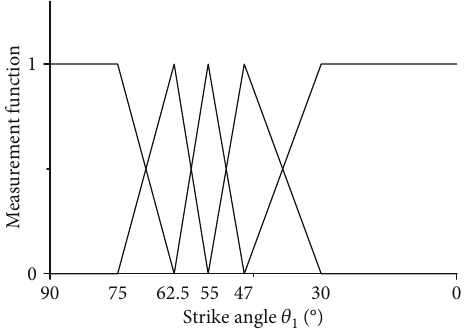
Figure 10: Uncertainty measurement function of rock moisture content.